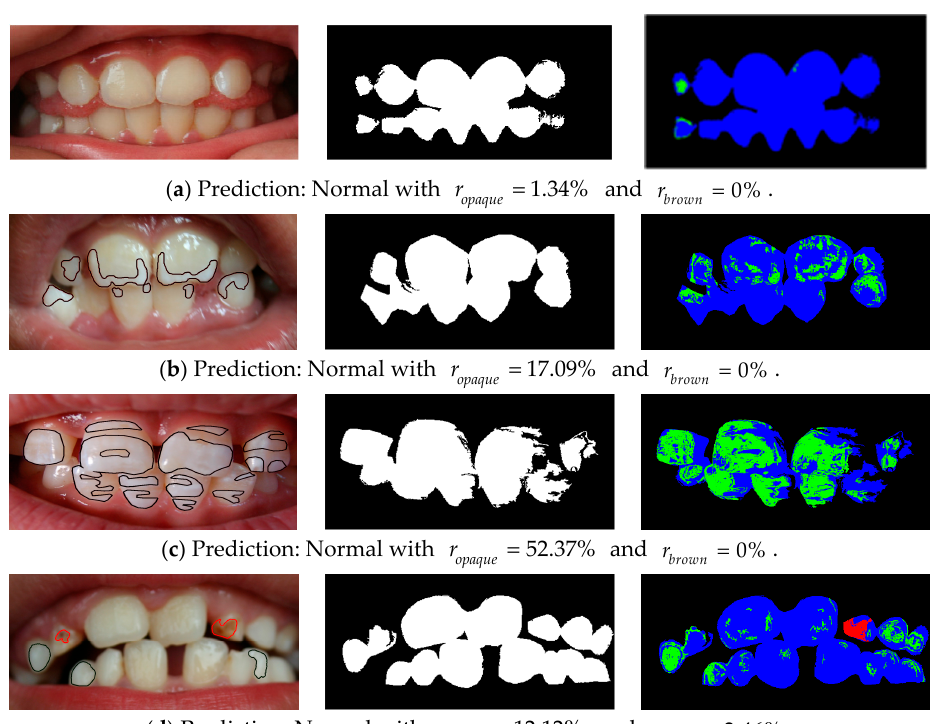
Figure 2. Examples with correct prediction of each fluorosis class from the blind test set and their segmented images: ( a ) Normal; ( b ) Stage 1; ( c ) Stage 2; ( d ) Stage 3. The left column presents the expert’s labels of opaque pixels and brown pixels, encircled in black and red, respectively. The center column presents the predicted binary tooth masks. The right column presents the predicted white–yellow, opaque, and brown pixels in blue, green, and red colors, respectively.